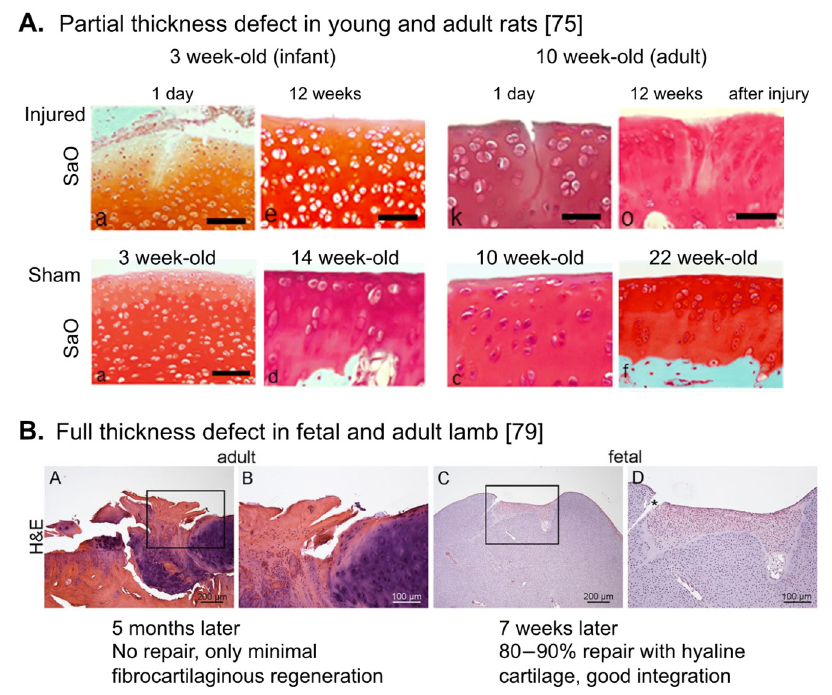
Figure 1. Repair activity in the fetal, young and adult articular cartilage. Histological changes of articular cartilage after introducing partial-thickness injury ( A ) and full-thickness injury ( B ) in the fetal ( B ), young/infant ( A ), and adult ( A , B ) animals. ( A ) Taken from Akatsu, et al. [75]. Note that hyaline cartilage repair with good integration was observed in 3 week-old infant rats. ( B ) Taken from Ribitsch, et al. [79]. SaO: Safranin O, H&E: Haematoxylin-Eosin staining.